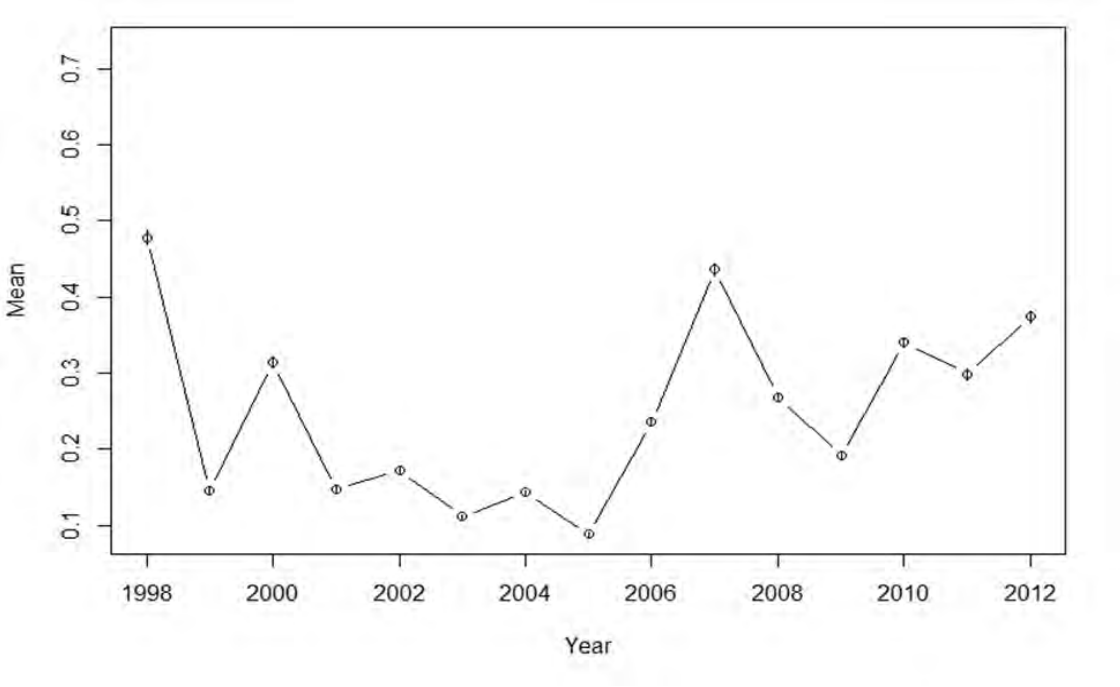
Figure 51. Abundance index for adult male horseshoe crabs (possessing male pedipalps) in New Jersey’s Surf Clam Dredge Survey (June, July,